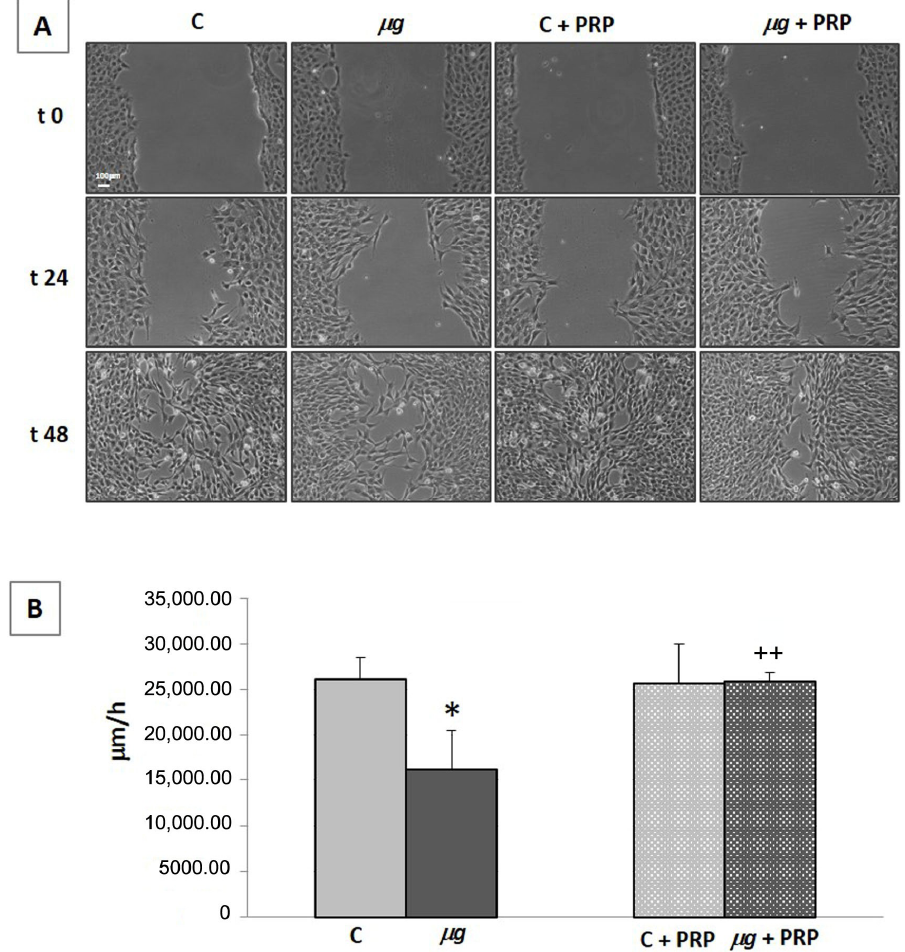
Figure 9. E ff ect of PRP treatment on NIH-3T3 cells exposed to modeled µ g : cell migration—scratch assay. The scratch assay was performed during 72 h exposure to modeled µ g , with or without PRP Figure 9. Effect of PRP treatment on NIH-3T3 cells exposed to modeled μg : cell migration— addition (1:1000). C = 1 × g . Photos of the scratch at di ff erent times ( A ); migratory speed expressed as scratch assay. The scratch assay was performed during 72 h exposure to modeled μg , with or µ m / h ( B ). Bar = 100 µ m. * p < 0.05 vs. C, ++ p < 0.05 vs. µ g, ( n = without PRP addition (1:1000). C = 1 × g . Photos of the scratch at different times ( A ); migratory speed expressed as μm/h ( B ). Bar = 100 μm. * p < 0.05 vs. C, ++ p < 0.05 vs. μg, ( n = 3).